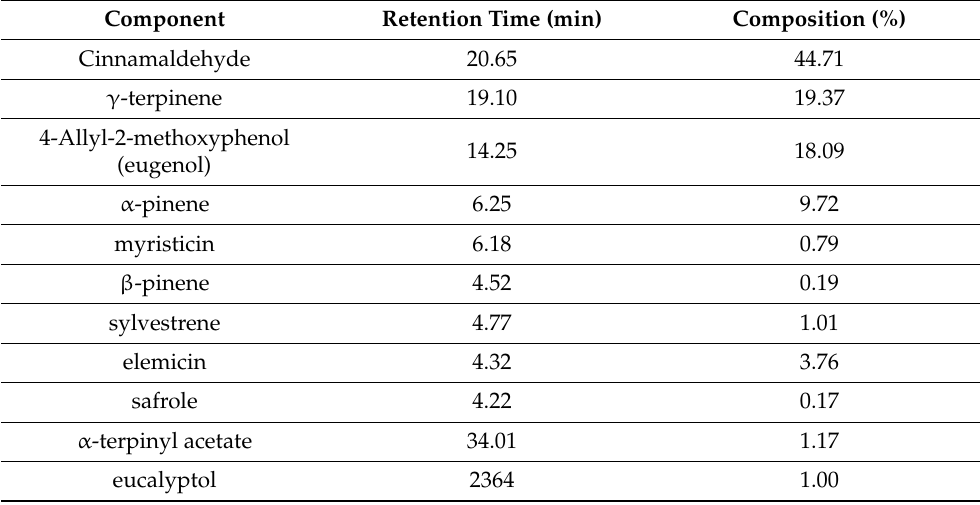
Table 3. Identification of Myristica fragrans aqueous extract bioactive compounds.